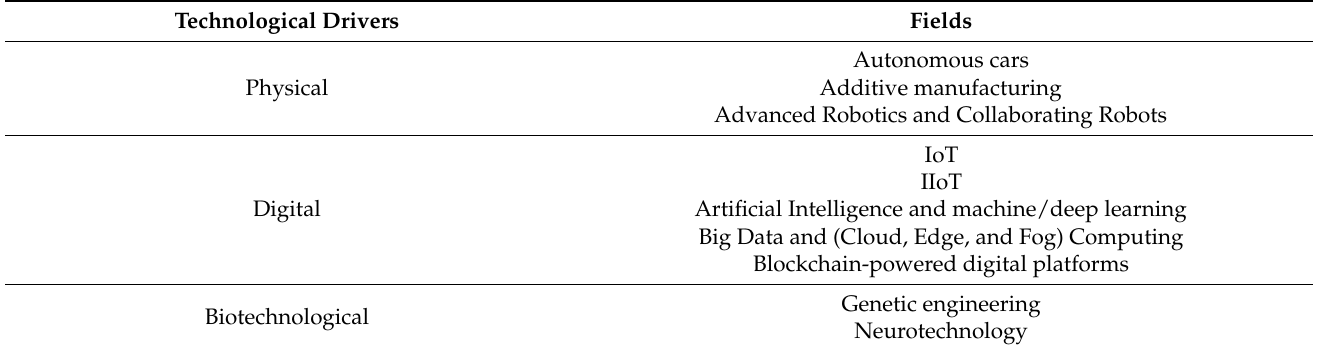
Table 2. Technology-based drivers for the 4th IR and application